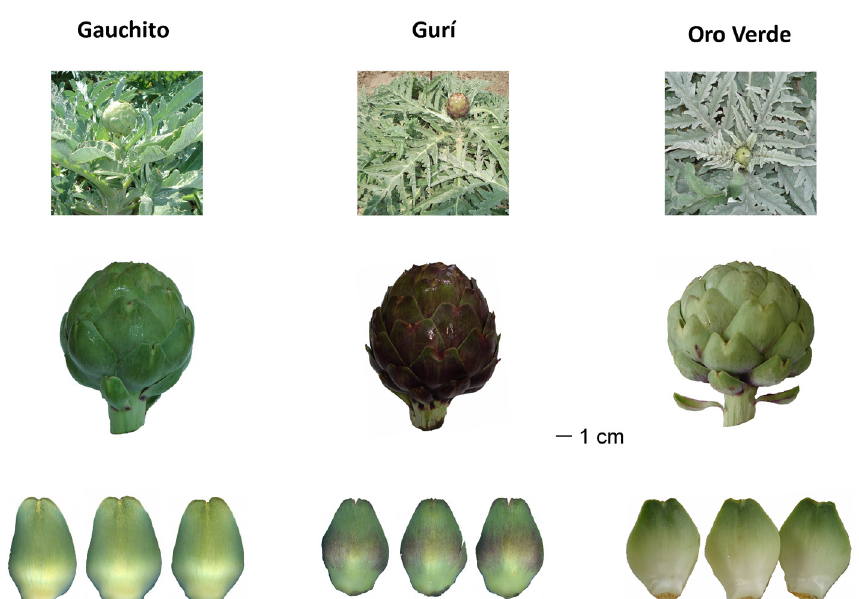
FIGURE 1 - Representative images of plants (first file), primary heads (second file), and edible central bracts (third file) from three artichoke cultivars Gauchito, Guri and Oro